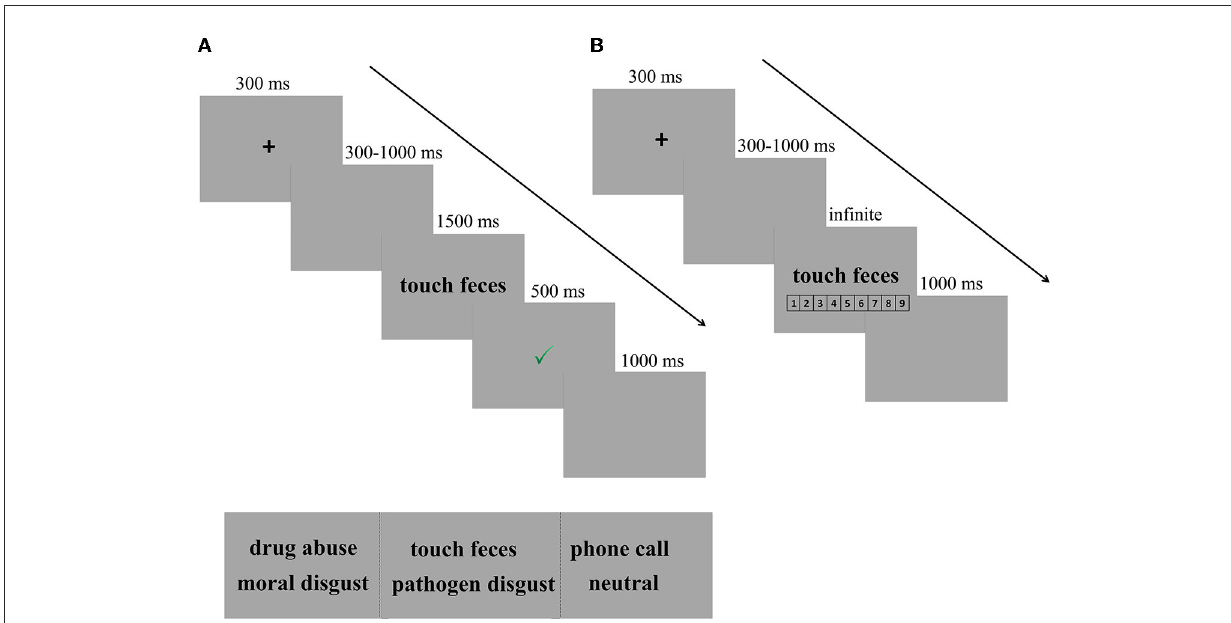
FIGURE1 Experimental design. (A) Trial of example in SC-IAT. In each trial, a fixation cross was presented for 300ms, followed by a blank screen ranging from 300 to 1,000ms. Then, the disgusting phrase (e.g., touch feces) remained on the screen until the participants responded or for 1,500ms, followed by a feedback for 500ms. Finally, there was a fixed blank for 1,000ms, indicating that one trial was completed. (B) Trial of example in explicit measures of disgust intensity. After completing the SC-IAT, participants were required to rate the intensity of the disgusted feelings provoked by each phrase on a scale from 1 (not disgusting at all) to 9 (very